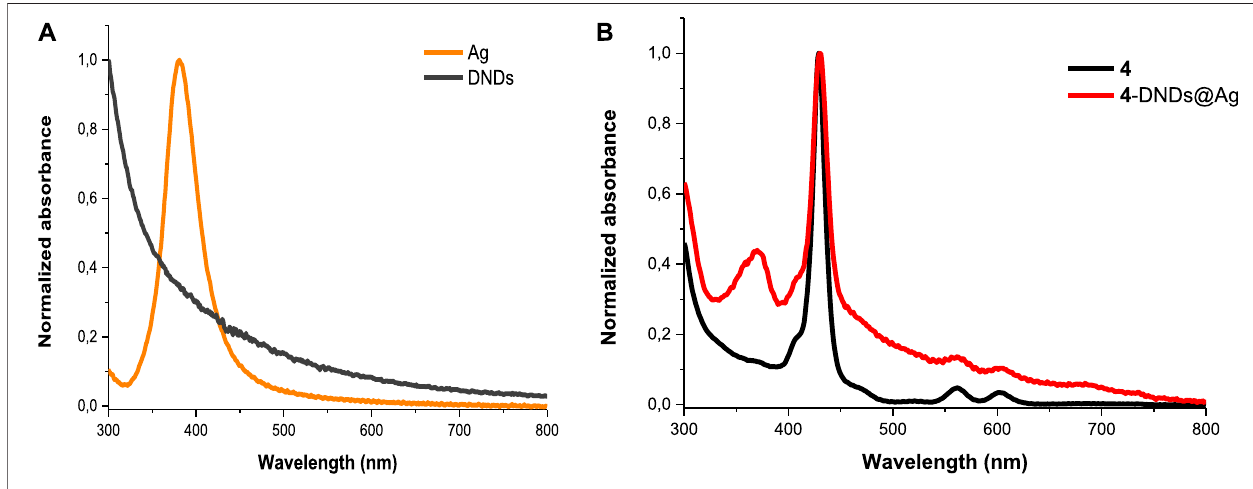
FIGURE 2 | Electronic absorption spectra of (A) DNDs and Ag NPs and (B) 4 and 4 -DNDs@Ag in DMSO (as an example).